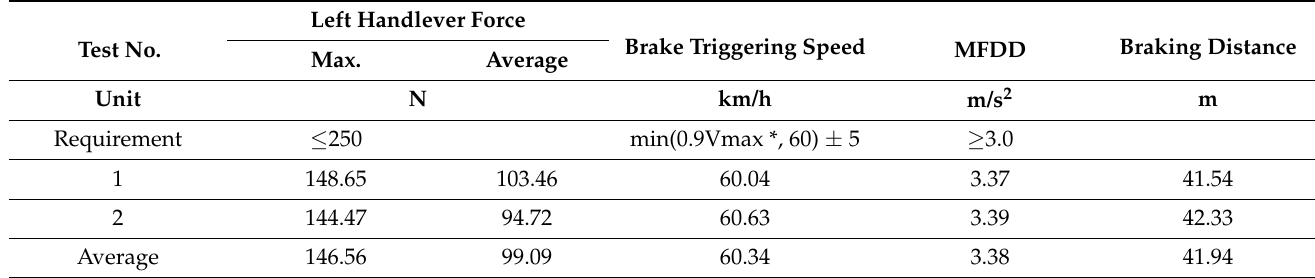
Table 3. Braking performance on front brake failure at laden